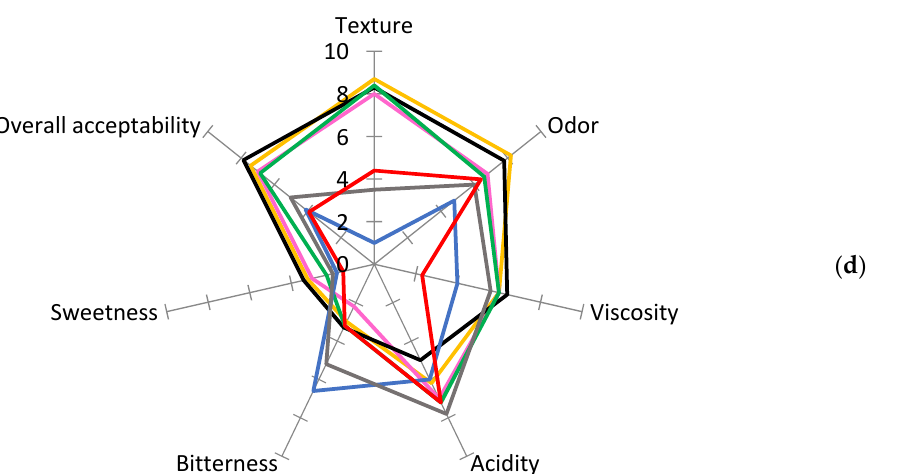
Figure 5. Sensorial analysis of the kefir. ( a – d ) Graphs represent the results of the testing of kefir obtained from whole cow’s milk (K_C), lactose-free cow’s milk (K_HD), goat’s milk (K_G), and sheep’s milk (K_S), respectively. Each kefir tested was indicated with the yeast involved in the fermentation: C. zeylanoides 13 ( ), D. hansenii 36 ( ), D. hansenii 78 ( ), K. Lactis 80 ( ), Y. lipolytica 92 ( ), and the yeast consortium ( ), without distinction among the species. The control trial was indicated as LbS ( ).